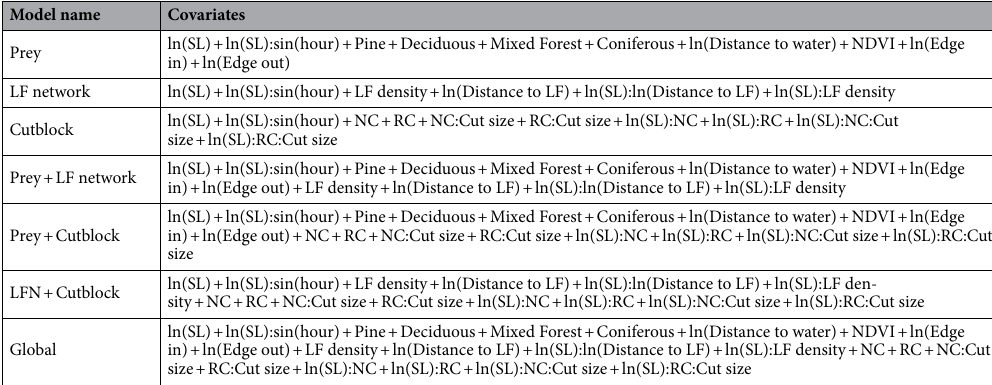
Table 1. Candidate models for the integrated step selection analysis examining wolf ( Canis lupus ) movement and habitat selection in Prince George South, 2018–2020. ln() = log-transformed covariate. SL step length, LF linear feature, NC new cut, RC regenerating